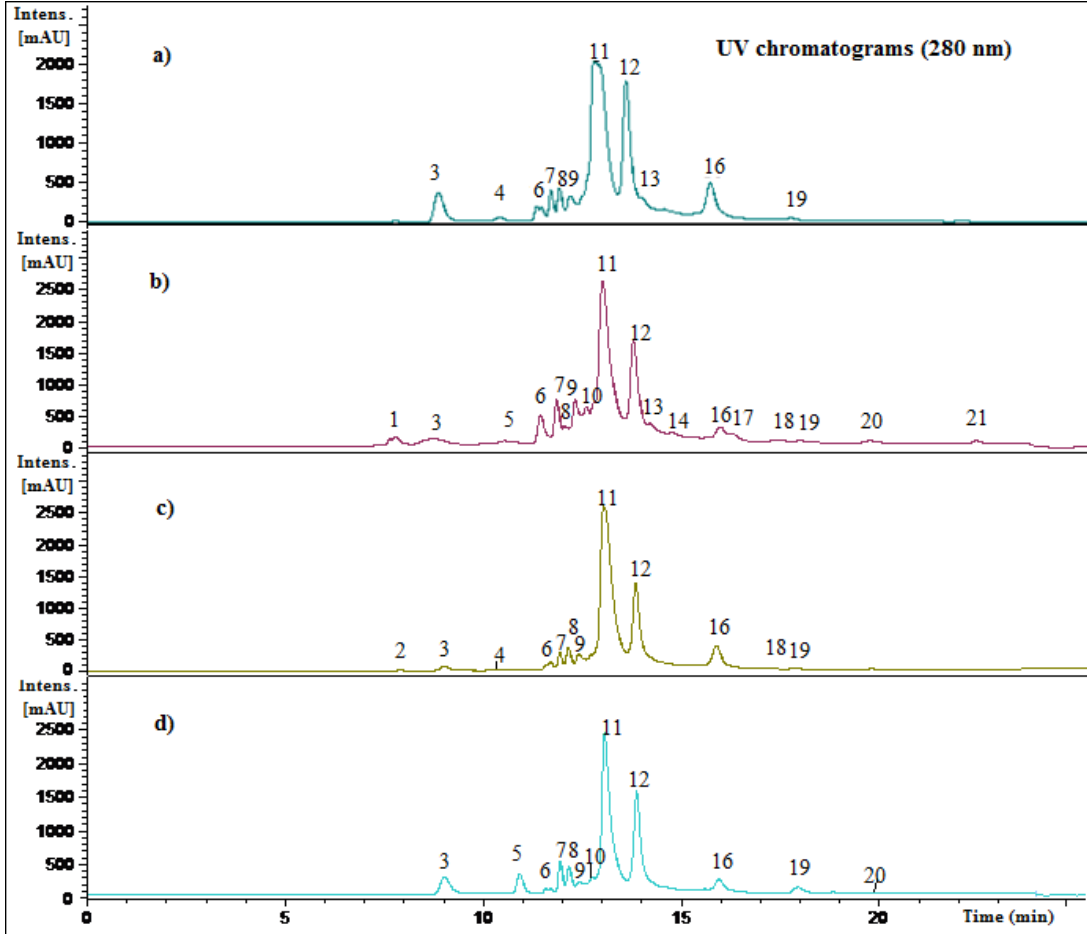
Figure 4. HPLC UV chromatograms at 280 nm of ( a ) Tommy Atkins mango fruits pulp extract, ( b ) Pica mango fruits pulp extract, ( c ) Tommy Atkins mango fruits peel extract and ( d ) Pica mango fruits peel